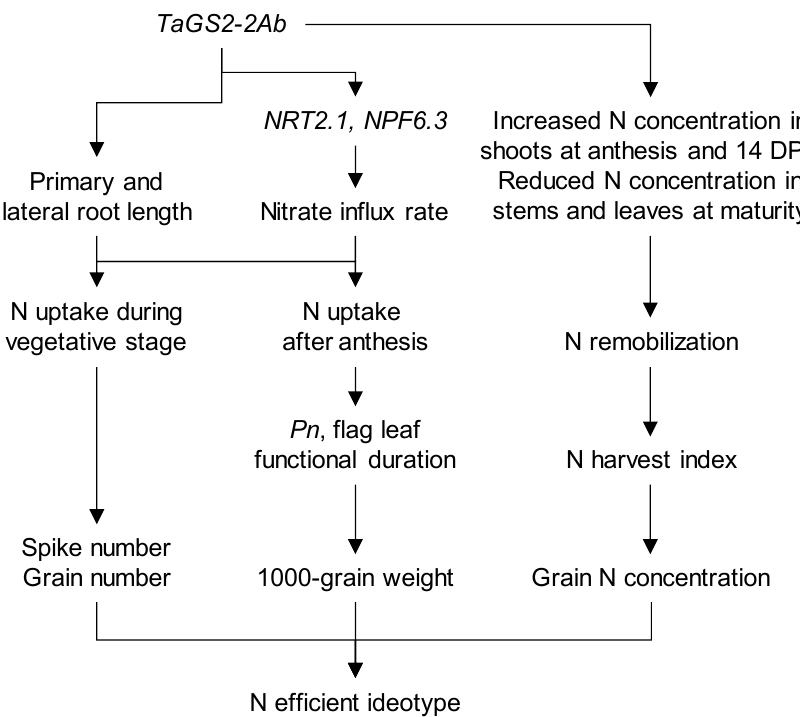
Figure 1. N efficient wheat ideotype mediated by the elite allele TaGS2-2Ab.